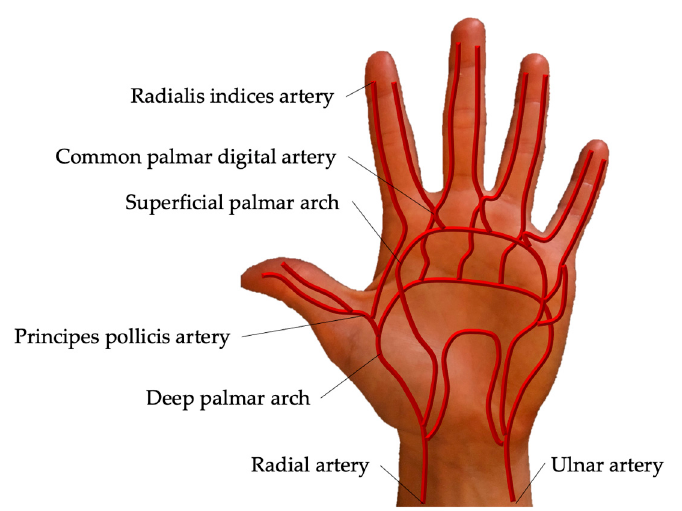
Figure 9. Palmar arch of the right hand. Entering the hand, the radial artery gives rise to the princeps pollicis artery and radial indices artery. The deep palmar arch is formed by the dorsal radial